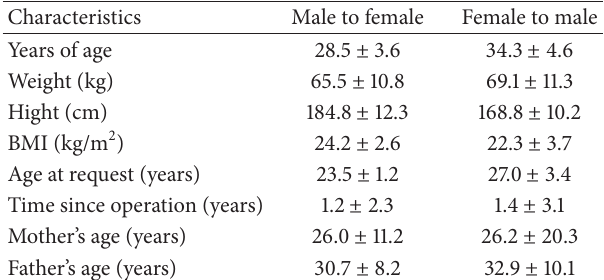
Table 1: Some characteristics of